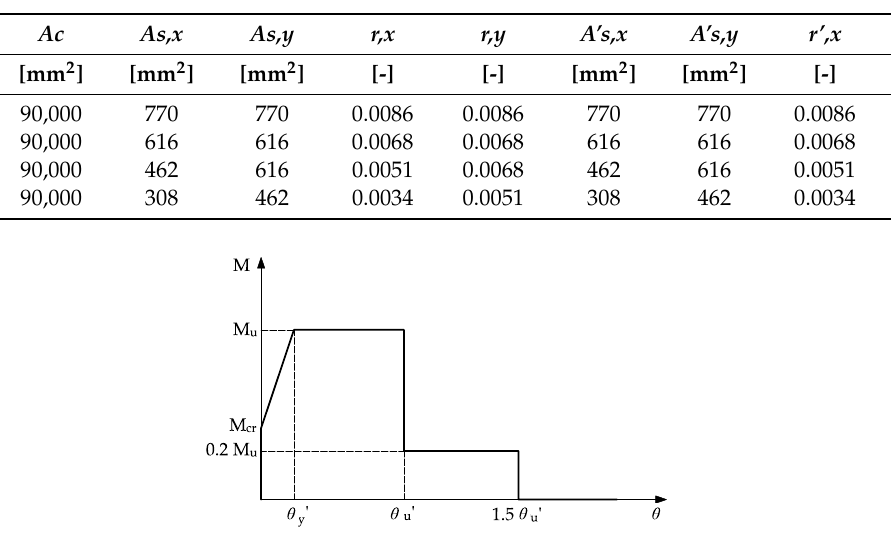
Figure 7. Moment-rotation constitutive behavior for a frame member-end considered in JASP 6.5, where M u is the ultimate bending moment, M cr is the first cracking moment, θ y ’ is the yielding rotation and θ u ’ is the ultimate rotation.